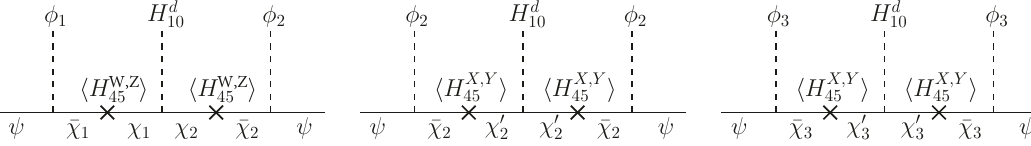
. These generate the down-type quark and charged lepton 10